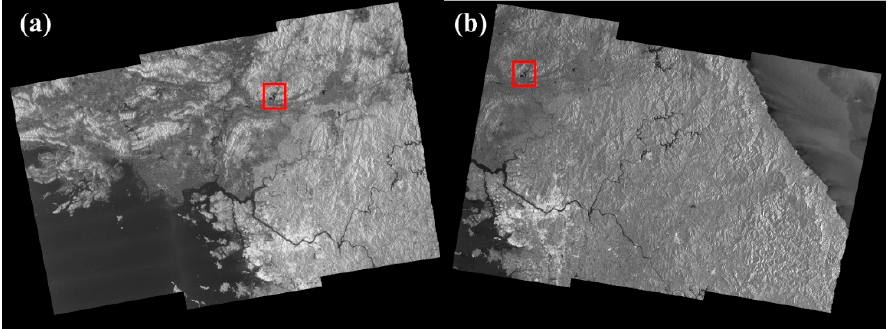
Figure 9. Intensity images of ( a ) Sentinel 1-A (2017 / 03 / 20) and ( b ) Sentinel 1-B (2017 / 03 / 26), which covers the Hwanggang Reservoir (red box).